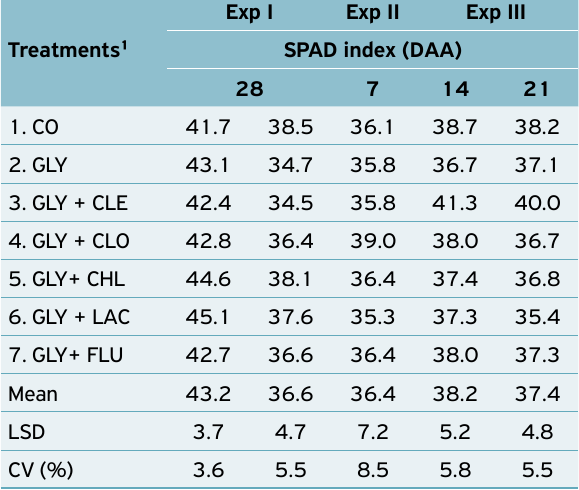
Table 5. SPAD index of RR2 soybean subjected to application of glyphosate, alone or in combination, at post‑emergence (V4).